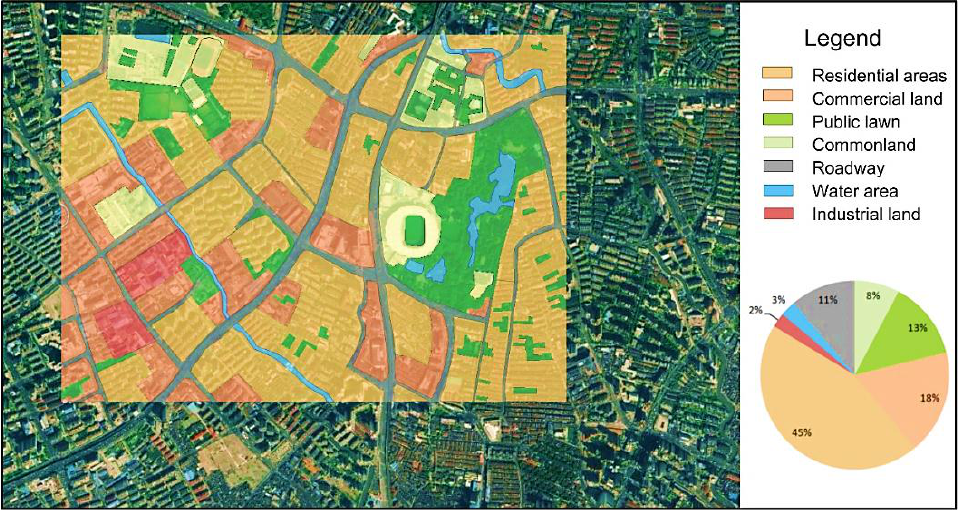
Figure 11. The map of land use classification in an area of 3.5 km 2 around the subsiding